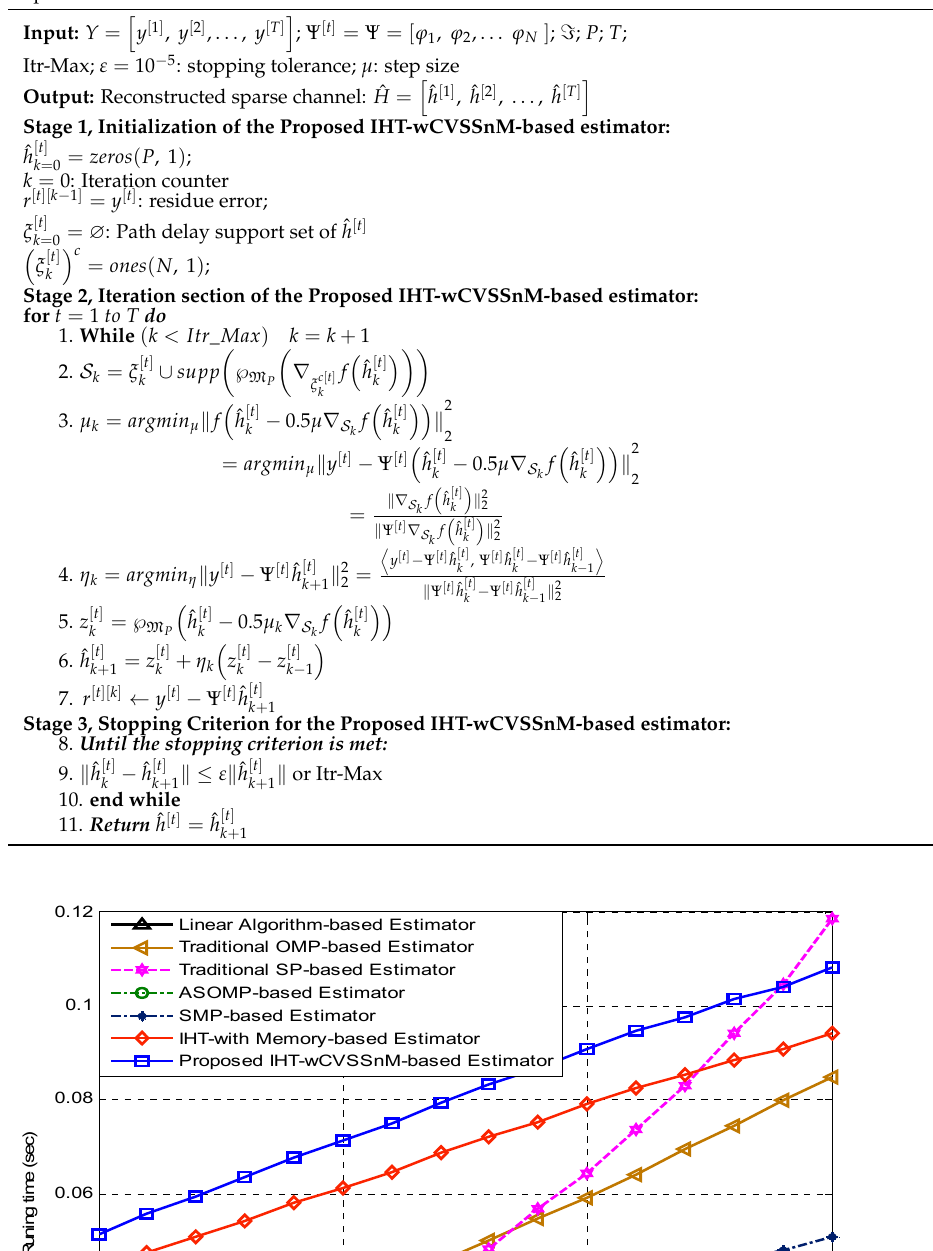
Algorithm 1 Proposed IHT-wCVSSnM-based Estimator for Wireless Communication systems with Dynamic Sparse Channels